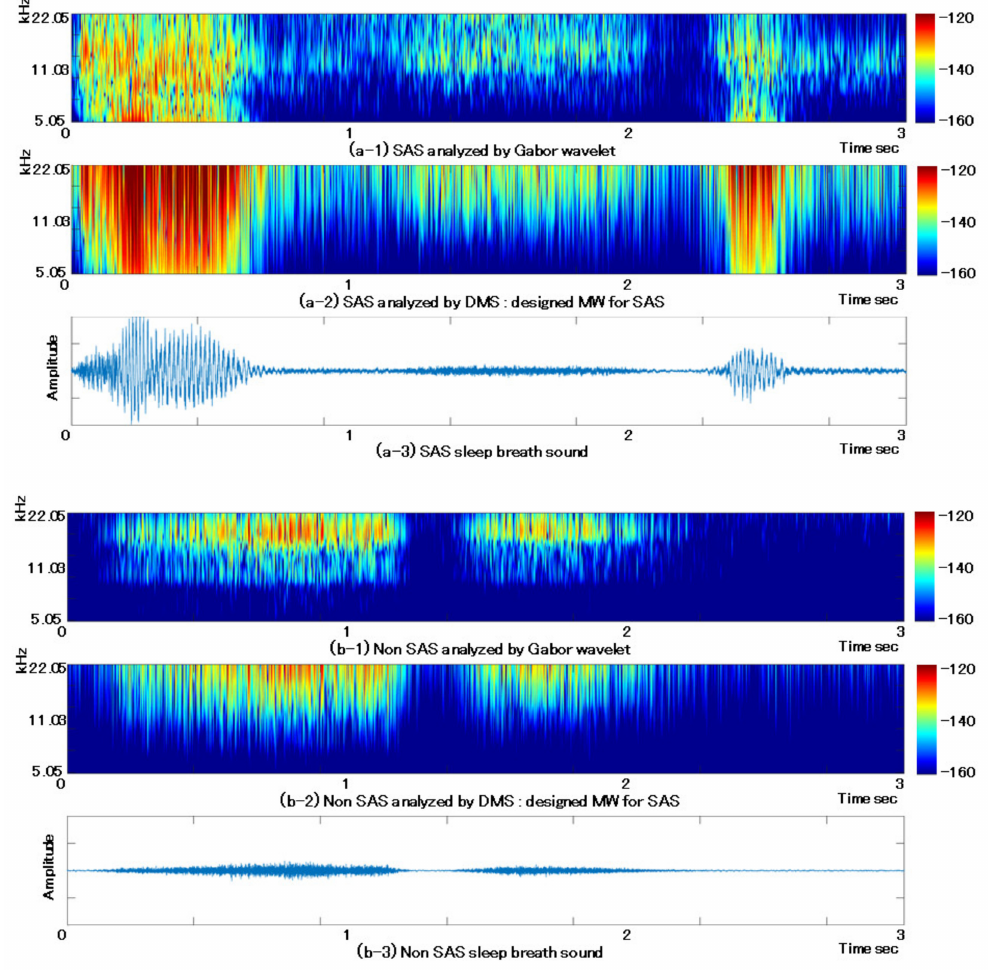
Figure 4. Comparison of breath sounds during sleep between SAS and non-SAS using GW and